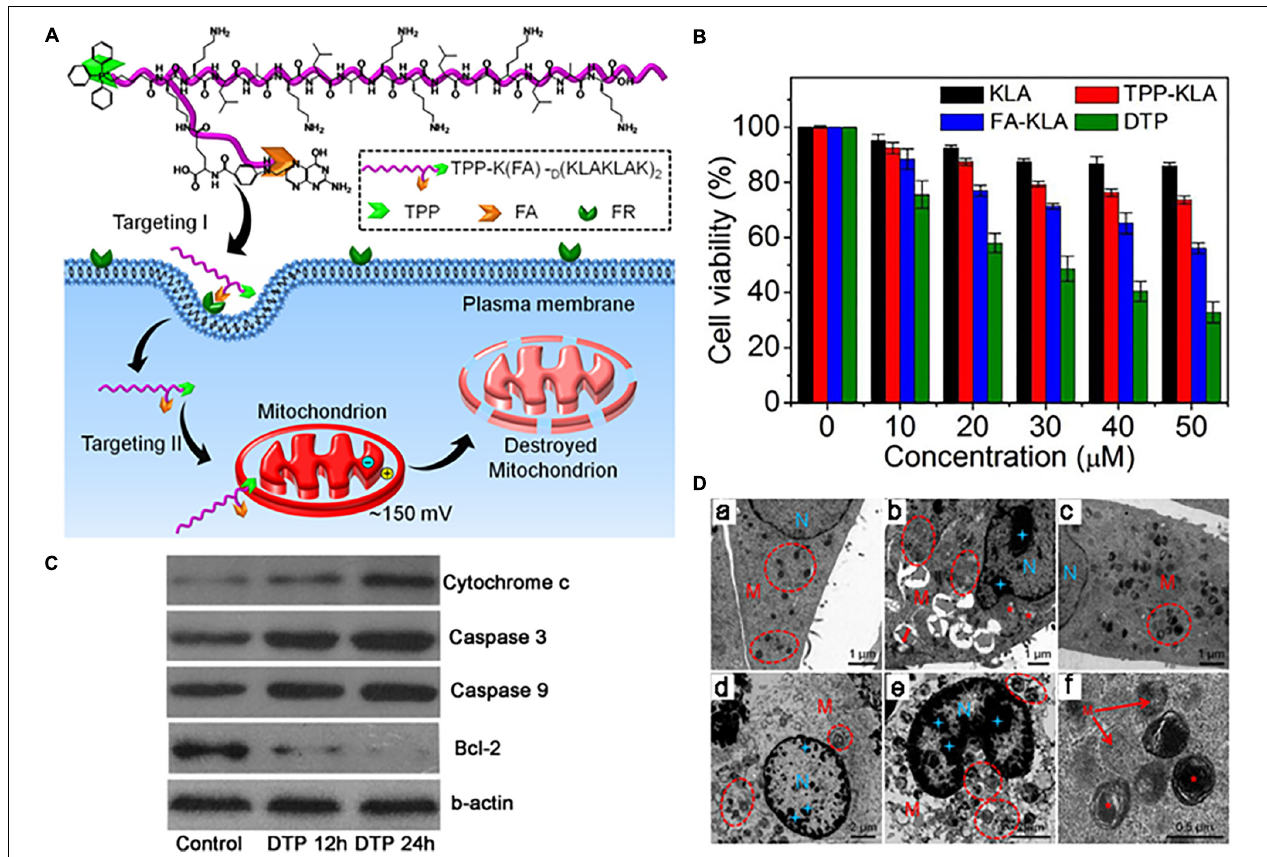
FIGURE 3 | (A) Dual-targeting pro-apoptotic peptide (DTP) to selectively target cancer cells and specifically damage mitochondria to lead to programmed cell death. (B) Cell viability of folate receptor (FR) (+) HeLa cells incubated with KLA, TPP-KLA, FA-KLA, and DTP for 48 h. (C) Western blot analysis of apoptosis-related proteins in KB cells incubated with DTP for different times, using β -actin as the control. (D) TEM images of (a) KB cells incubated with no DTP, (b,c) KB cells incubated with DTP (20 mM) for 12 h, and (d) enlarged circled area in (c) . (e,f) KB cells incubated with DTP (20 mM) for 24 h. Mitochondria (M) are highlighted by red circles and red pentacles. Nucleus (N) is highlighted by blue doji stars. Images were adapted with permission from reference (Chen et al.,